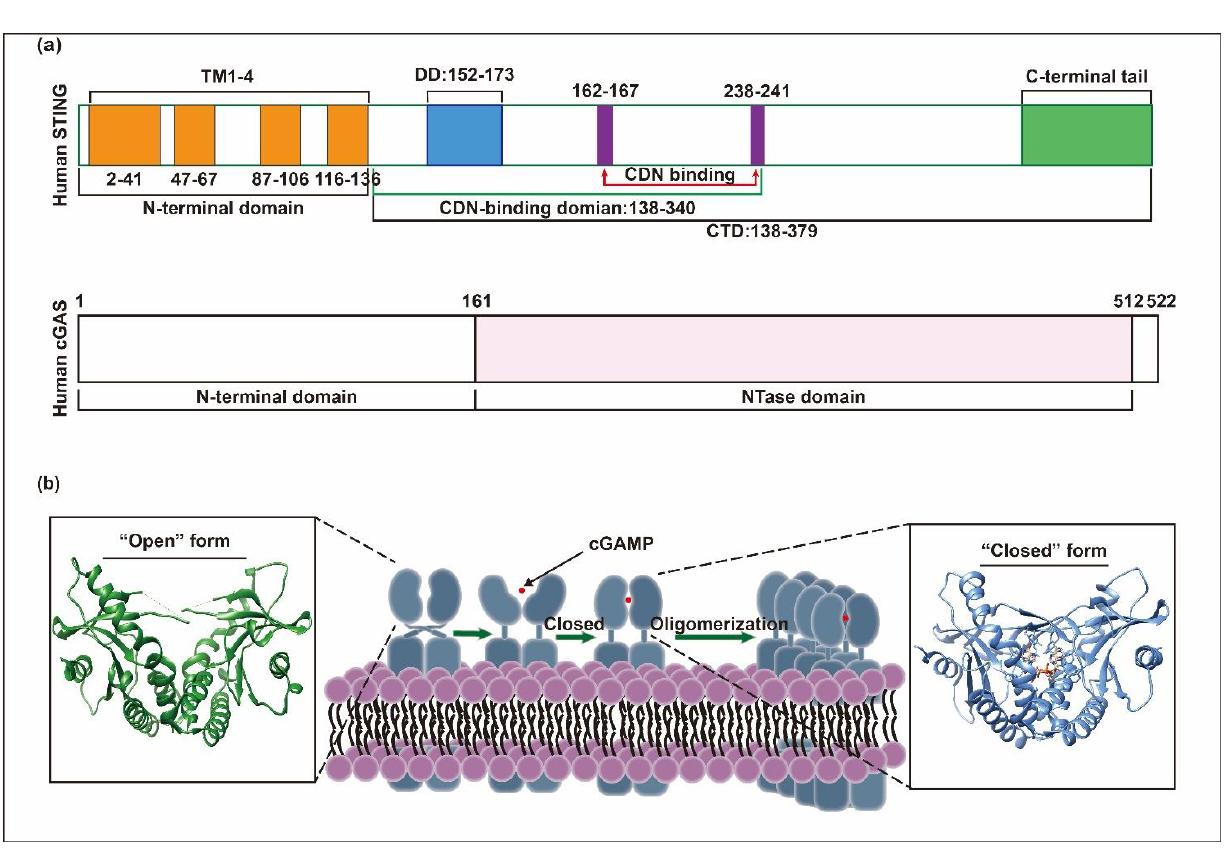
Figure 1. Structural basis of cGAS-STING [21,33]. ( a ) The domain composition of human-STING and human-cGAS. ( b ) STING oligomerization occurs after binding to cGAMP. Human-STING (colored in green, PDB ID:4EMU) and human-STING binds with 2 ′3′ cGAMP (colored in cornflower blue, PDB ID:4LOH).